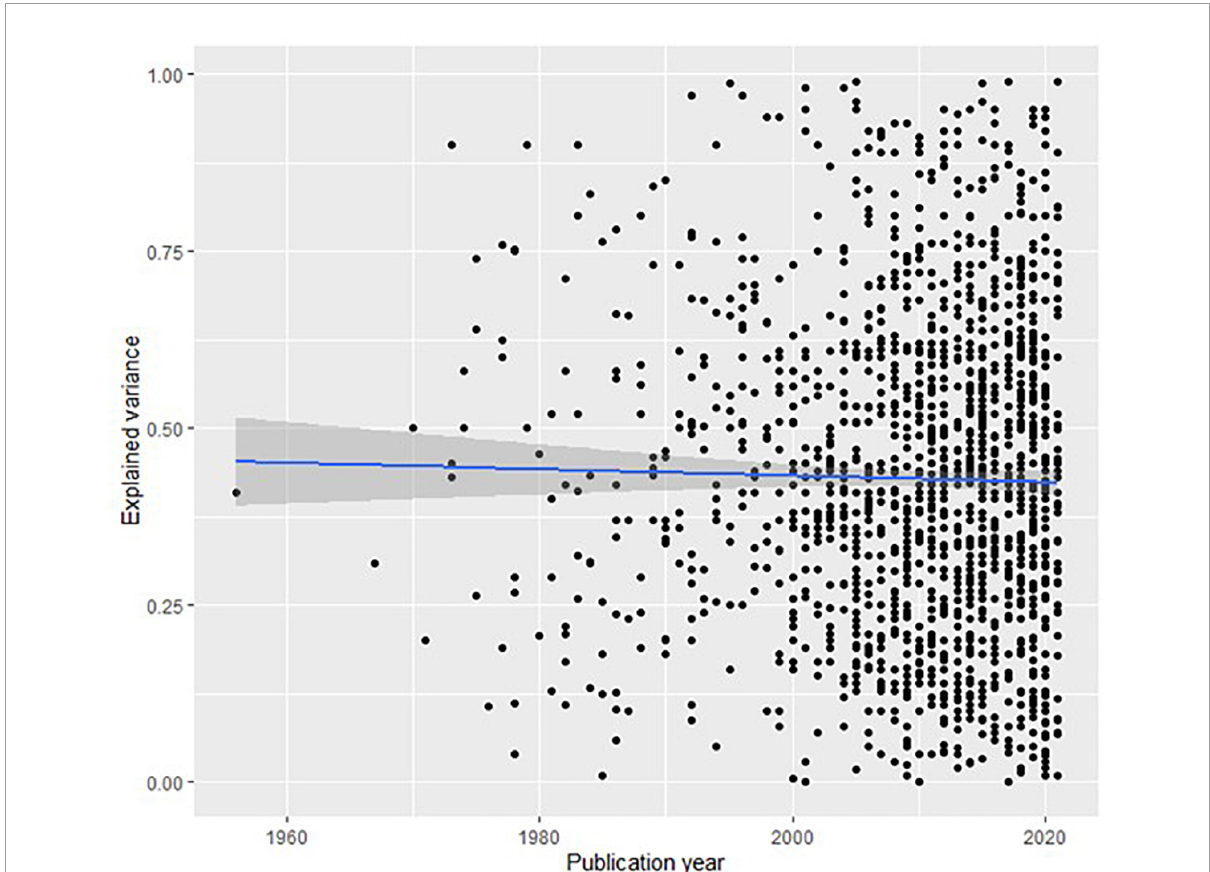
FIGURE2 Dot plot of explained variance per year for 1,565 articles in PsycINFO (with 95% confidence intervals). Regression line models the mean explained variance per